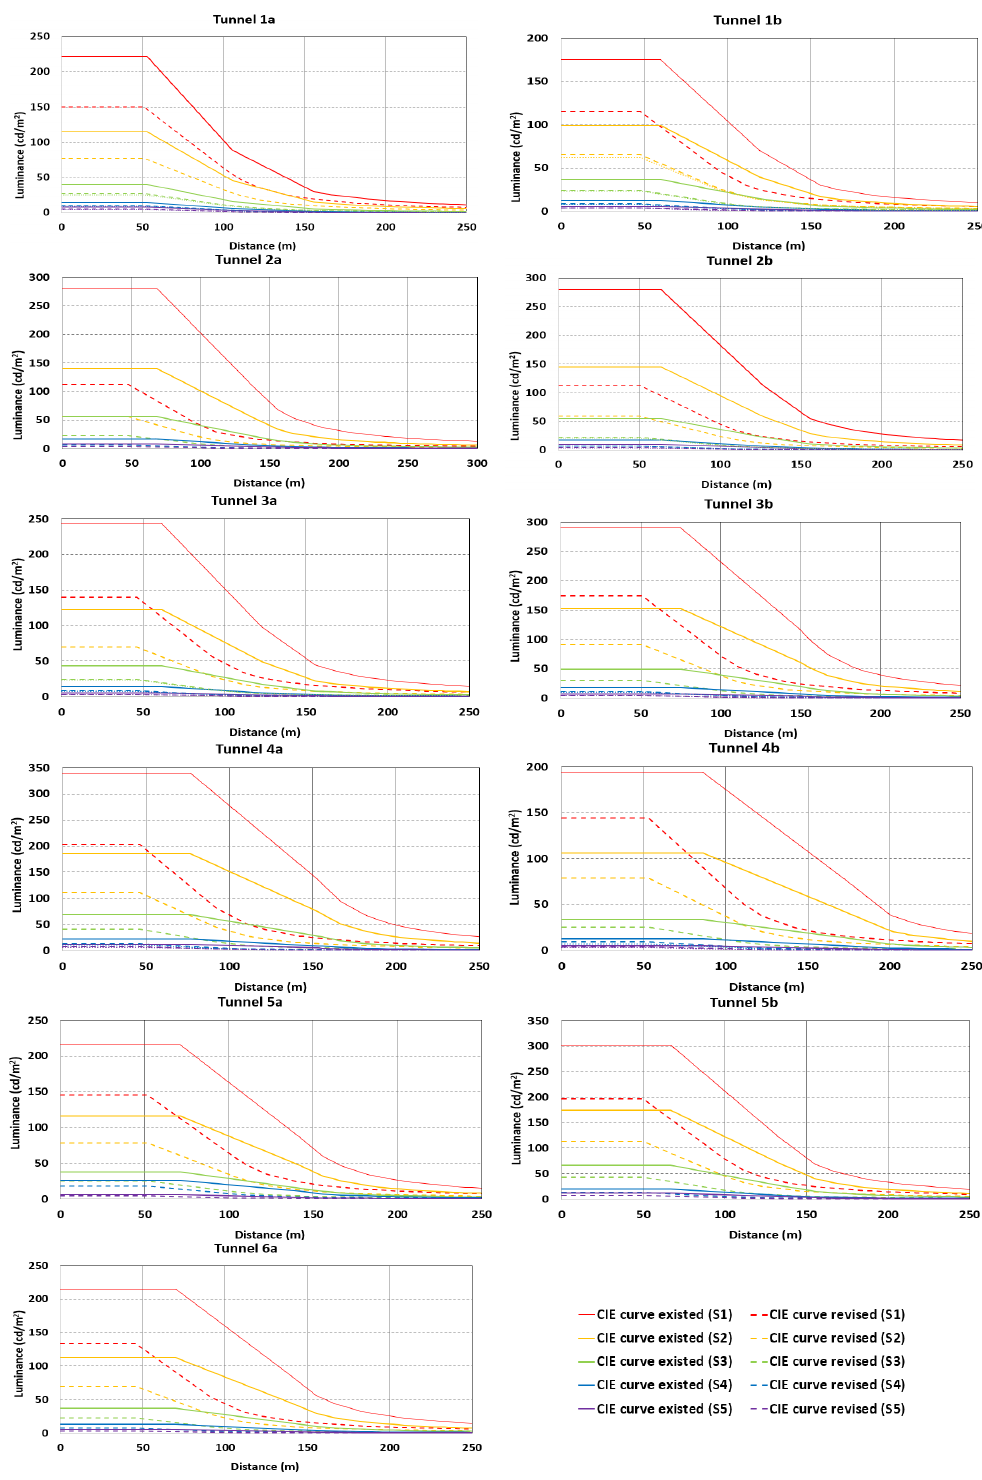
Figure 4. Luminance curves from initial design (existing lighting system) and from the tra ffi c weighted method using the new calculated Lth’ values, according to the Commission Internationale de l’Eclairage (CIE) for the examined